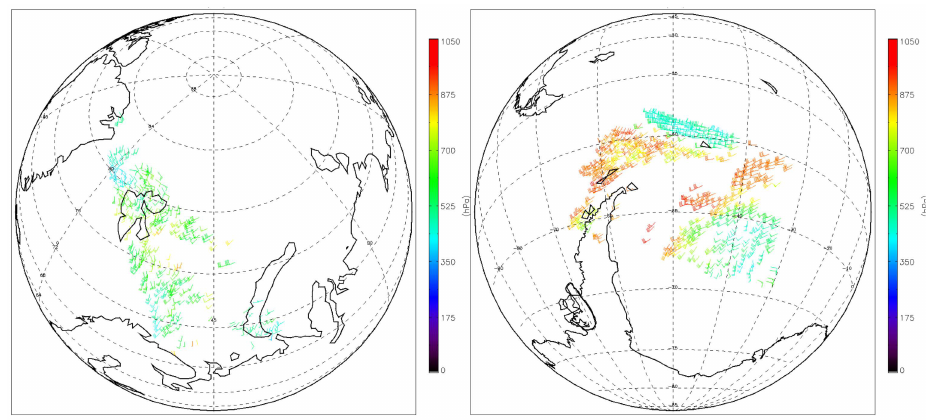
Figure 3. First single AVHRR AMVs extracted with Metop-C data the 4 December 2018 at 13:21 UTC over the northern polar region (left) and at 14:03 UTC over the southern (right) polar